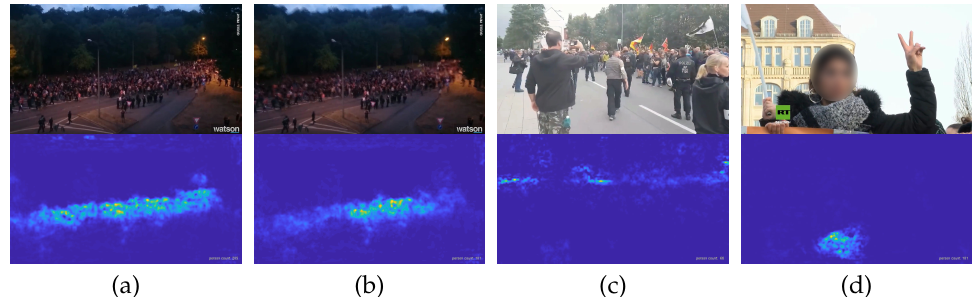
Figure 16. Exemplary results for three different demonstrations in Chemnitz and in Berlin from 2018 (original images from YouTube, urls given in the text). ( a , b ) Two consecutive video frames, where ( b ) is slightly blurred due to camera motion. While the person count is predicted with 205 for ( a ), it drops to 101 for the blurry image ( b ). ( c ) Person count prediction is 68 for this image. ( d ) The algorithm fails and classifies the texture of the scarf as a highly dense crowd, resulting in an incorrect prediction of 101